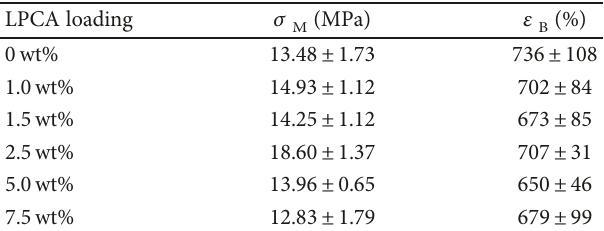
Table 5: Tensile strength ( σ LPCA-WPU elastomers with di ff erent loadings of